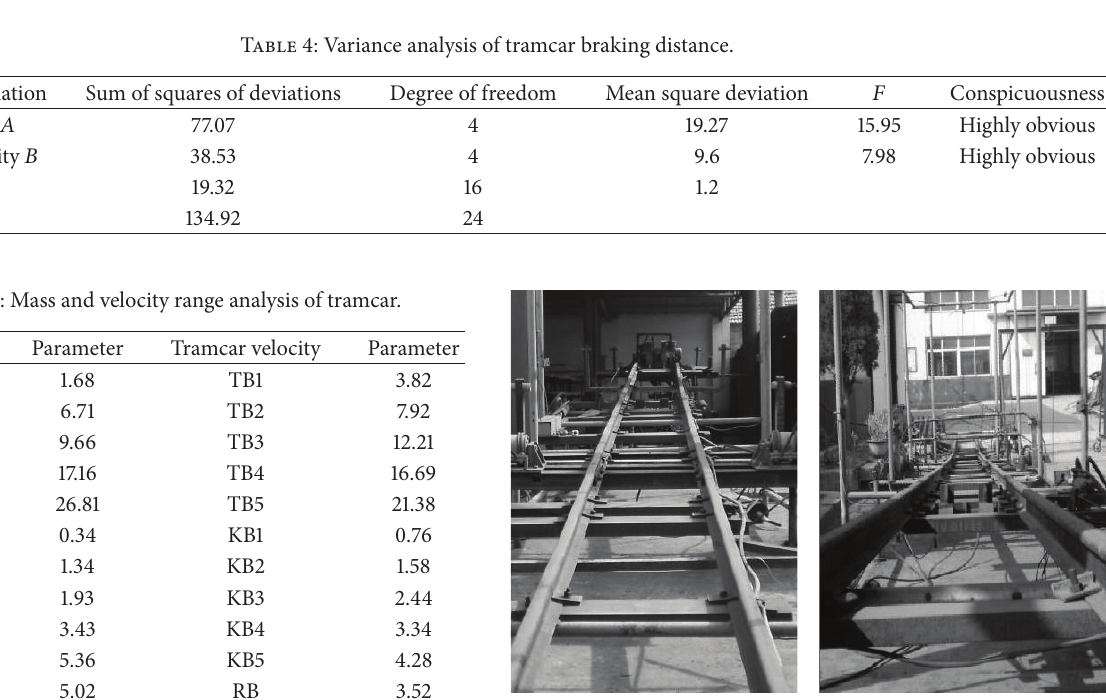
Figure 9: Experiment field of tramcar slipped protection equip-